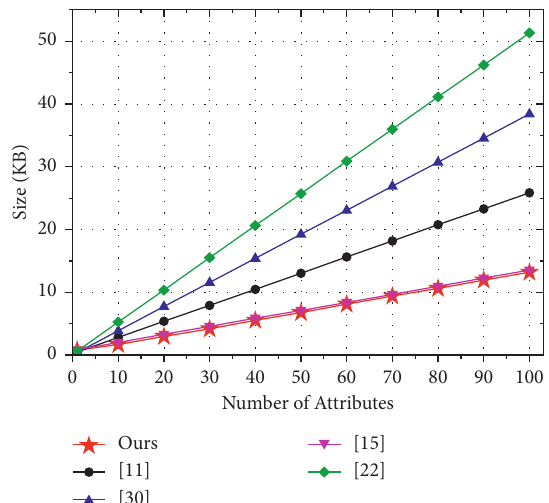
Figure 8: Simulating results of attributing size.